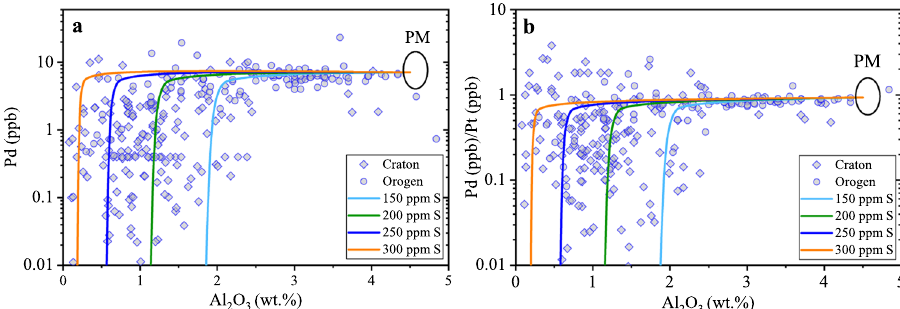
Fig. 4 Comparison of the Pd content and Pd/Pt ratio of Earth ’ s mantle peridotites with those of our model calculations. a, b Our model calculations were performed by partial melting of Earth ’ s primitive mantle (PM), with Al 2 O 3 content (wt.%) in the residual mantle as a proxy for the degree of partial melting. The used D SL = SM Pt ; Pd values are 4000 and 2000, respectively. The black ellipses refer to the Pd content and Pd/Pt ratio of the PM (refs. 34,35 ). Mantle peridotite Pt, Pd, and Al 2 O 3 data were taken from refs. 28, 29 and references therein. This fi gure illustrates that the Pd content and Pd/Pt ratio in Earth ’ s mantle peridotites can be largely explained by PM partial melting with D SL = SM Pt ; Pd values of 4000 and 2000, respectively. Source data are provided in Supplementary Data